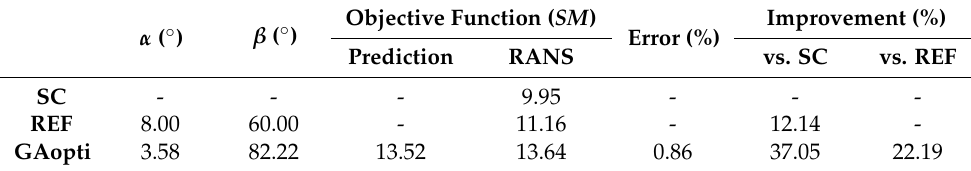
Table 4. Comparison of objective function value between optimized design and other cases.